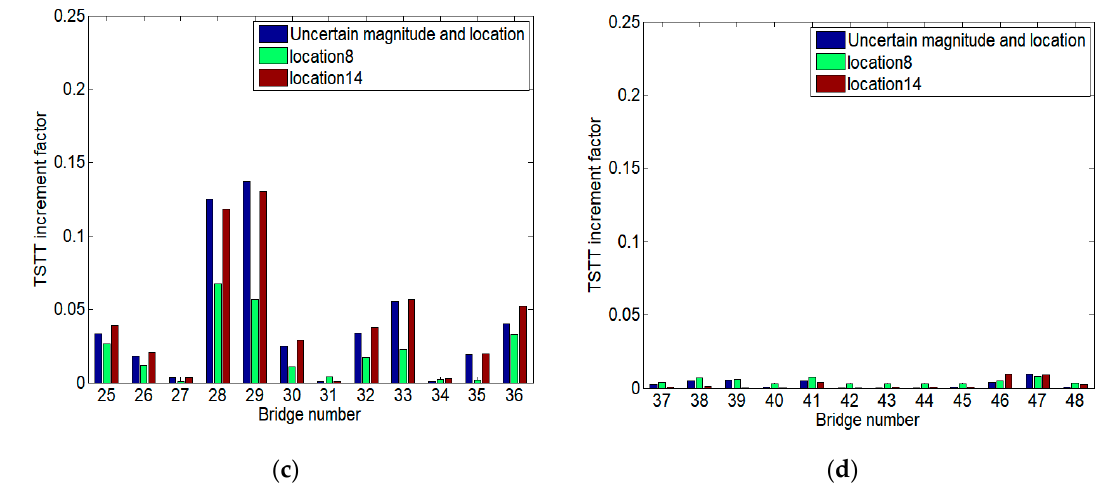
Figure 12. Relative importance of bridge number ( a ) 1 to 12, ( b ) 13 to 24, ( c ) 25 to 36, and ( d ) 37 to 48.